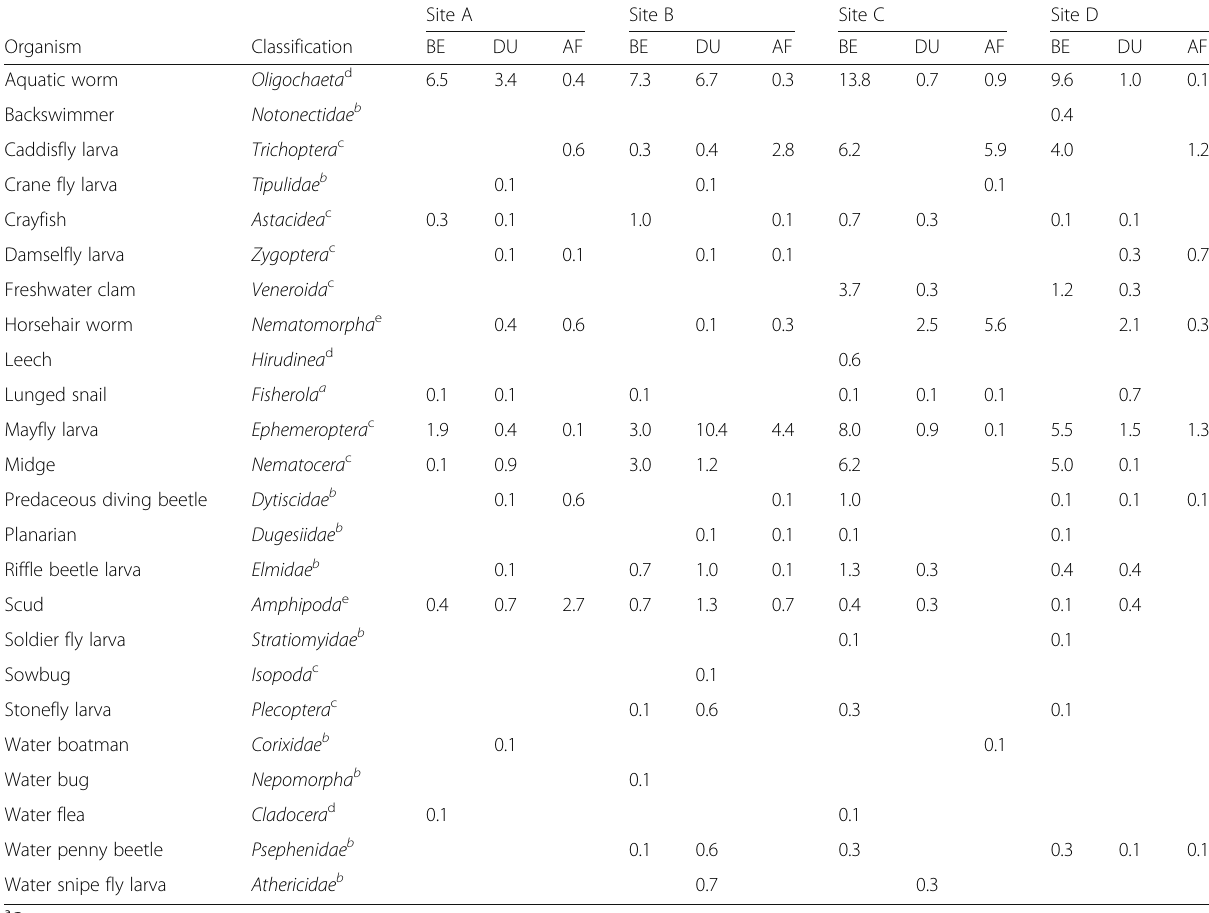
Table 2 Composition and mean abundance (individuals/m 2 ) of benthic macroinvertebrates at the four sampling sites during the periods before (BE), during (DU), and after construction (AF). Missing values indicate that no specimens were